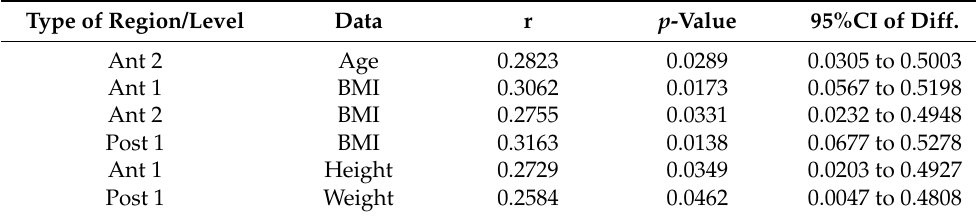
Table 8. Correlation (Pearson R coefficient test) between the superficial fascia of the arm ultrasound measurements and the descriptive data. Only statistically significant data are reported.